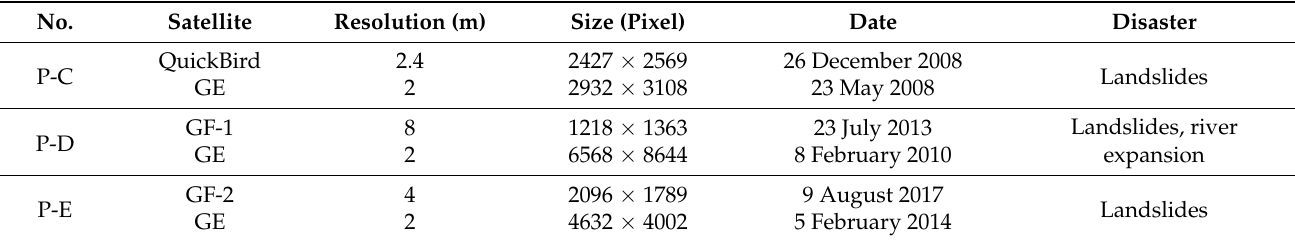
Table 3. Details of HR multispectral images with disaster